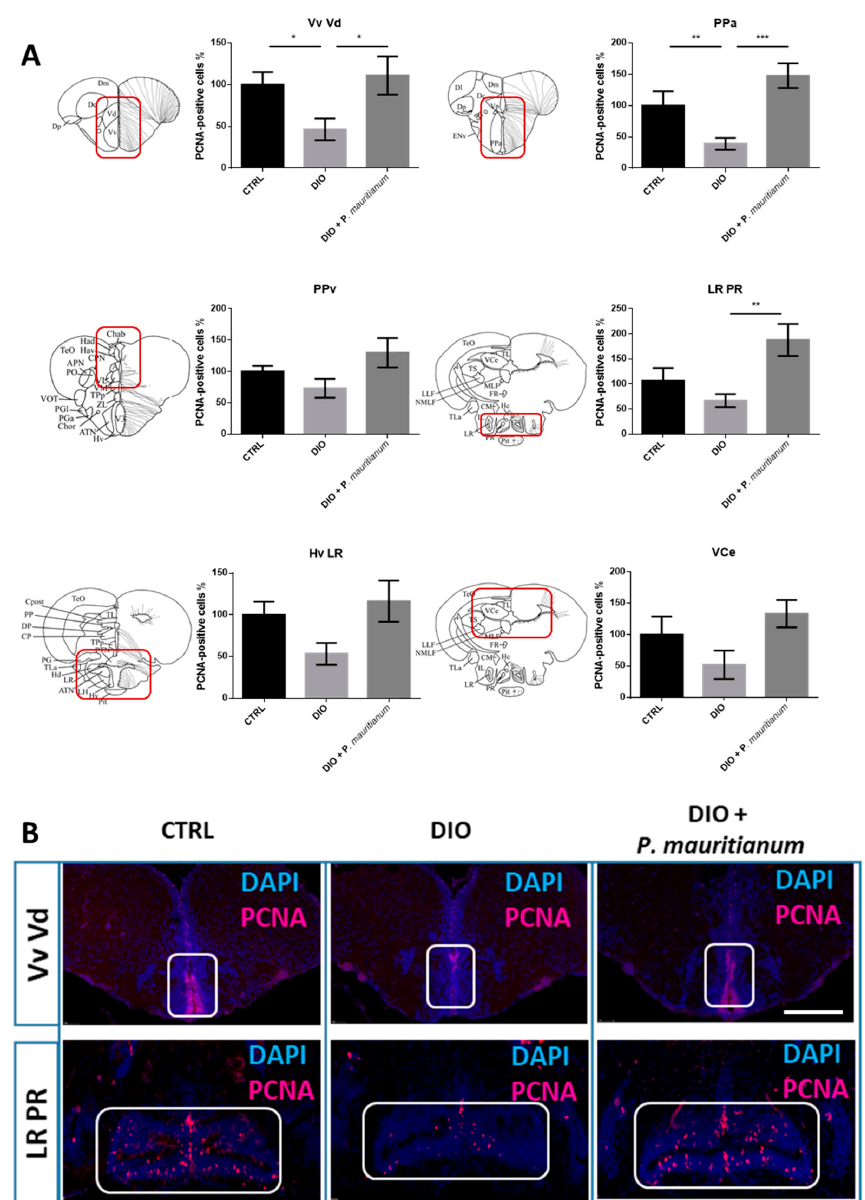
Figure 8. DIO reduced proliferation in the main neurogenic niches while P. mauritianum treatment rescued it. ( A ) Statistical analysis of the number of proliferative cells (PCNA-positive) in CTRL, DIO and DIO + P. mauritianum -treated zebrafish. The respective brain schemes correspond to the transversal sections of the zebrafish brain for each studied region, showing the main brain domains/nuclei according to the Zebrafish Brain Atlas from Wullimann et al., and were adapted from Pellegrini et al. [61,62]. DIO + P. mauritianum fish displayed neurogenesis similar to controls in the main neurogenic niches studied. ( B ) Representative pictures of PCNA immunohistochemistry (red) and cell nuclei counterstaining (DAPI in blue) on vibratome brain sections of CTRL (left) and DIO- treated fish (middle) and DIO + P. mauritianum -treated zebrafish (right). n = 5–10 number of brains studied pooled from two independent experiments. Bar graph: standard error of the mean (SEM). Student’s t -test: * p < 0.05; ** p < 0.01; *** p < 0.001. Bar = 150 µ m. Vv: ventral nucleus of ventral telencephalic area; Vd: dorsal nucleus of ventral telencephalic area; PPa: parvocellular preoptic nucleus, anterior part; PPv: periventricular pretectal nucleus; Hv: ventral zone of periventricular hypothalamus; LR: lateral recess of diencephalic nucleus; PR: posterior recess of diencephalic ventricle; VCe: valvula